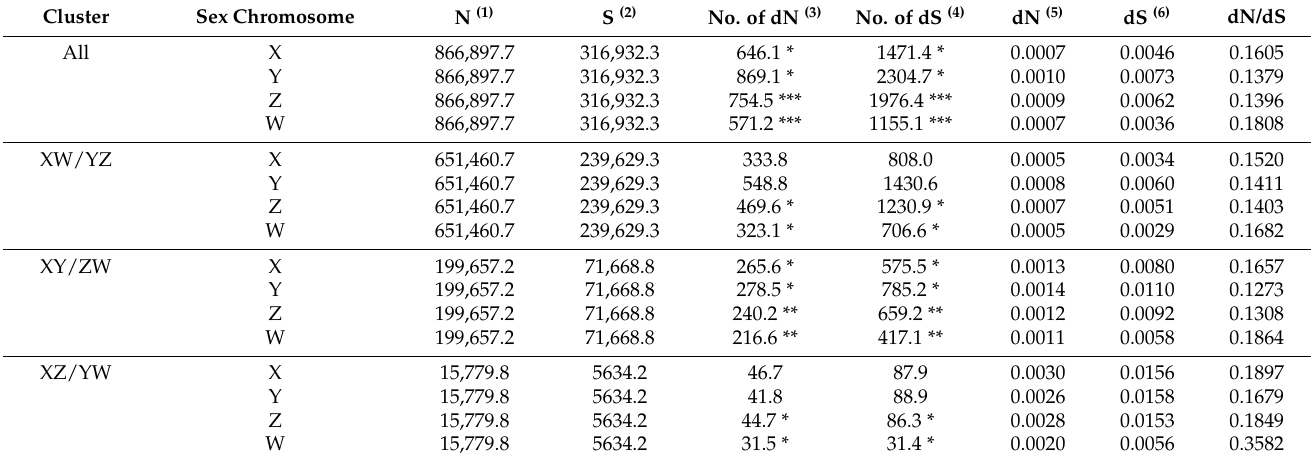
Table 1. Numbers of synonymous and no-synonymous nucleotide substitutions in sex-linked